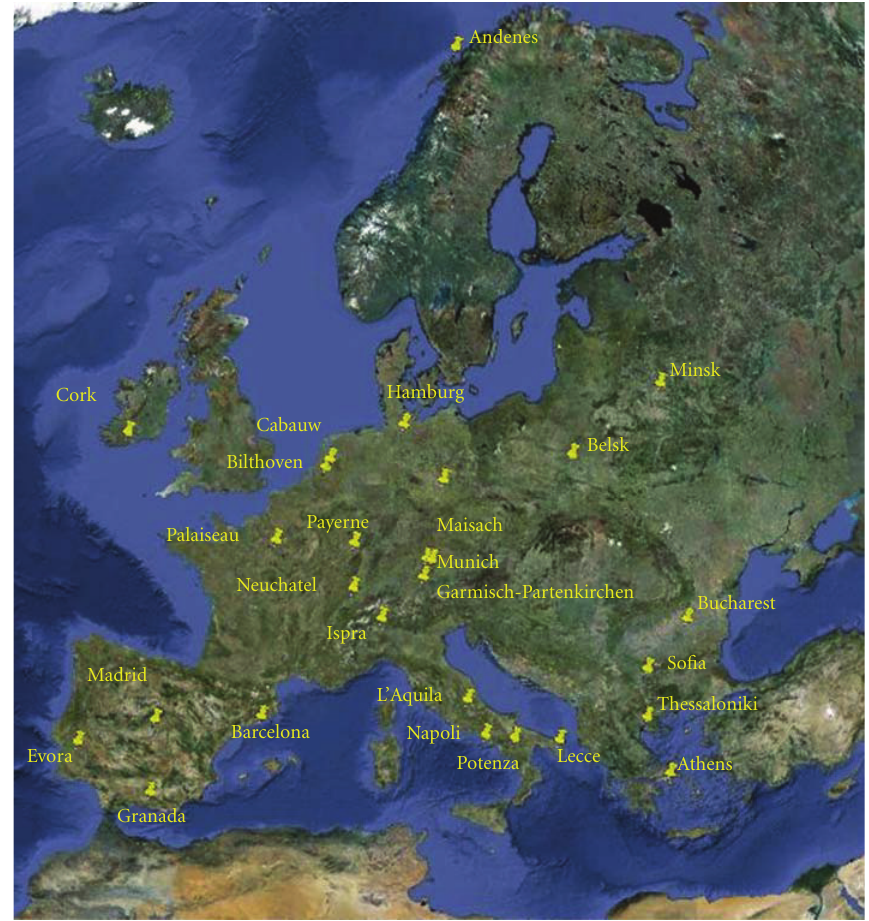
Figure 3: Map of EARLINET (European Aerosol Research Lidar Network) stations. The number of the stations is continuously growing. The map reports the status at February 2012. Further stations in France, Germany, Israel, Georgia, and Turkey are going to join the network in the next